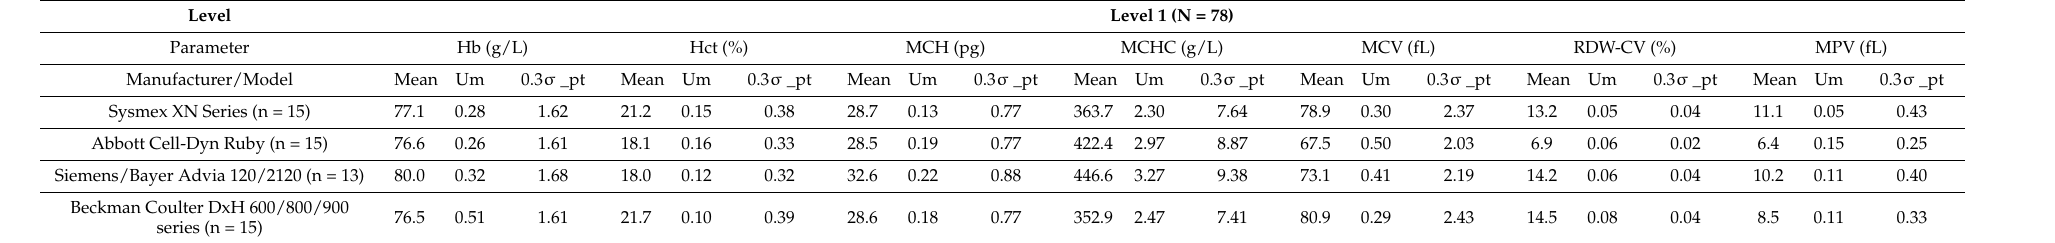
Table 4. Evaluation RBCs, PLT parameters of CBC EQA material by instrument